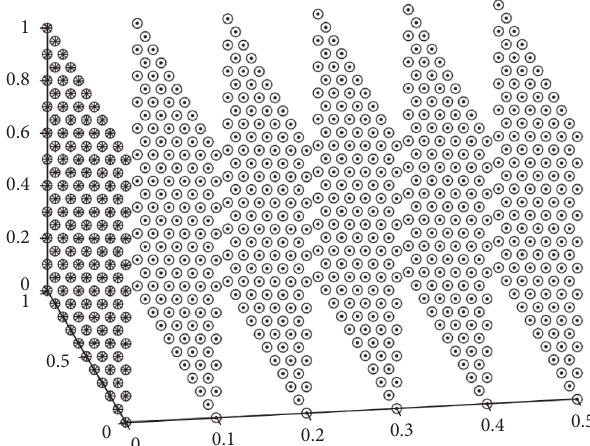
Figure 1: Configuration of the space-time